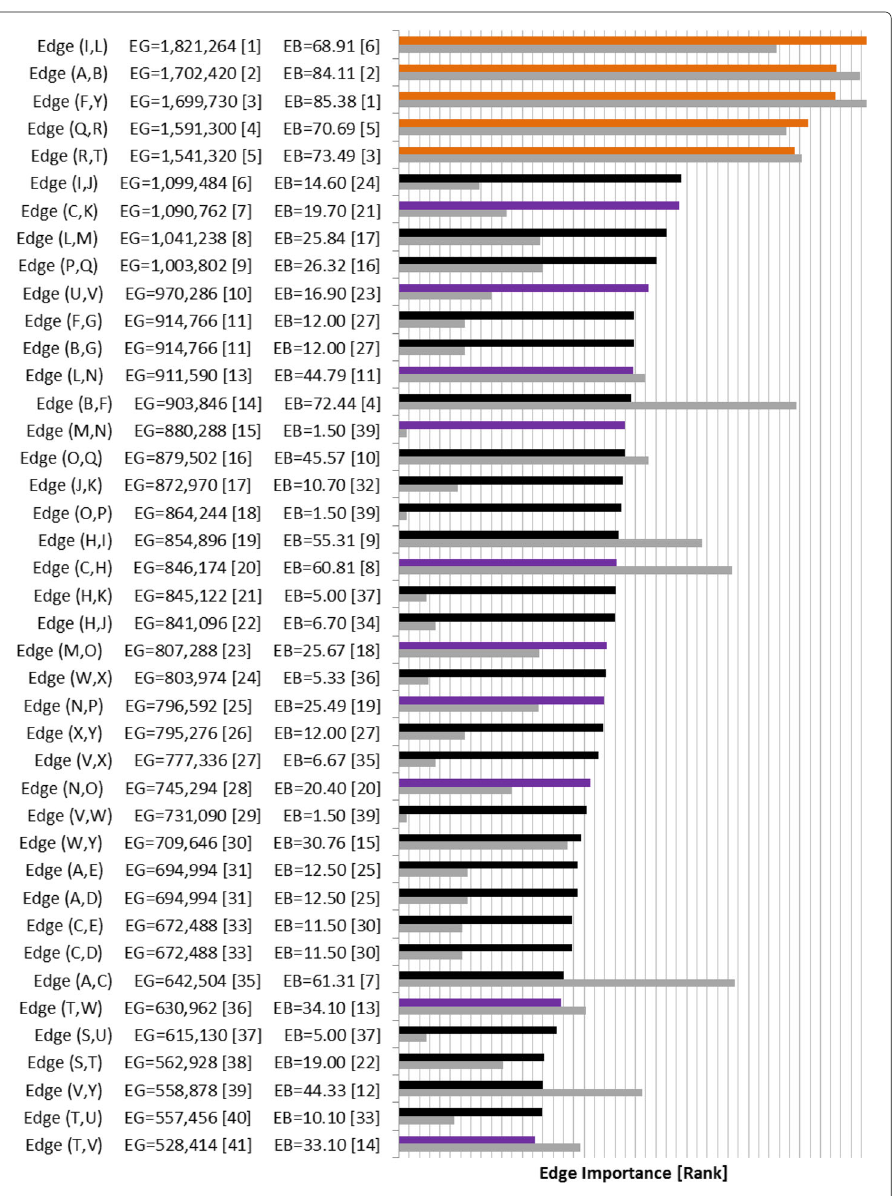
the bridges to nowhere and reanalyzed the resulting network structure to discover that edge (4,7) remains the highest-ranking edge, while the edges ranked second and third change places with each other. Edge (3,9), Barbadori-Medici, increases slightly in rela- tive Edge Gravity and is ranked fourth in the new network (out of a total of 15 edges). The Edge Gravity Algorithm solution for k ∗ = 33, found by solving successively for k = 1, 2, 3, . . . , 33, is shown in Figs. 16 and 17. Notice that once the bridges to nowhere have been removed, no edges stand out as being involved in dramatically fewer paths than the